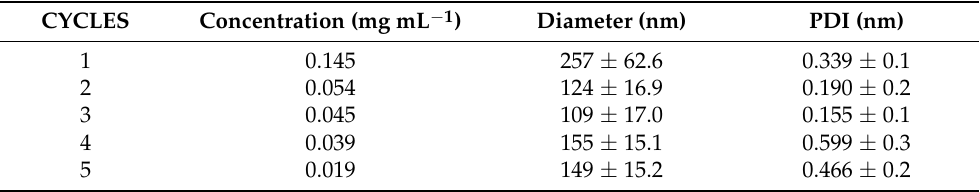
Table 2. Yield and size of molecularly imprinted polymers (MIP) nanoparticles (mg mL − 1 ) after five successive cycles. The diameter of the particles and polydispersity index value